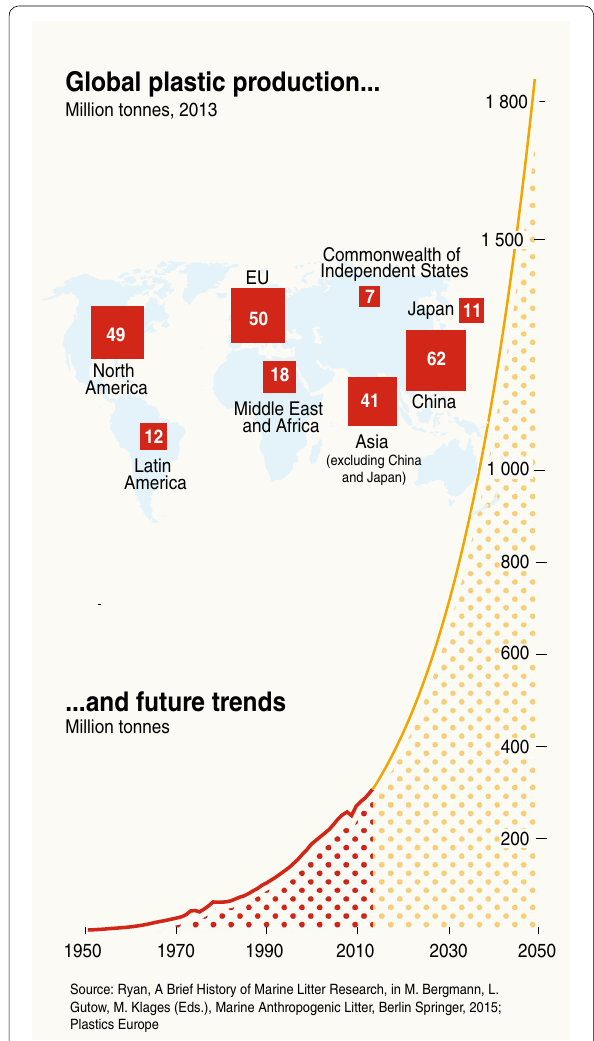
Fig. 1 Global plastic production and future trends (Source: UNEP. Marine plastic debris and microplastics—Global lessons and research to inspire action and guide policy change [3]); Marine Litter Vital Graphics- www.grida.no. Cartographer: Maphoto/Riccardo